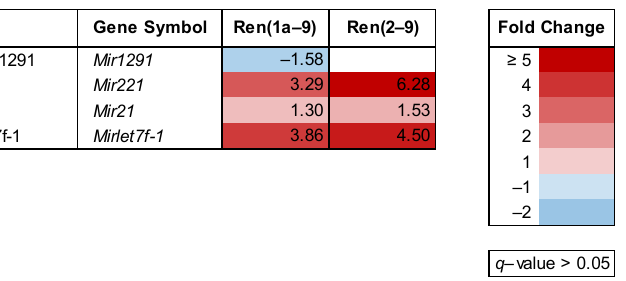
Figure 3. Alterations in the expression of genes coding for microRNAs. The transcript levels were identified by microarray analyses as a result of either Ren(1a–9) or Ren(2–9) overexpression as com- pared with pIRES H9C2 control cells. The red color indicates genes with increased mRNA levels and the blue color indicates those with decreased mRNA levels as compared with pIRES controls, while the white color indicates not significantly altered genes with q > 0.05. Shown are only significantly altered genes ( q < 0.05) of selected miRNAs involved in glucose uptake or AKT/mTOR